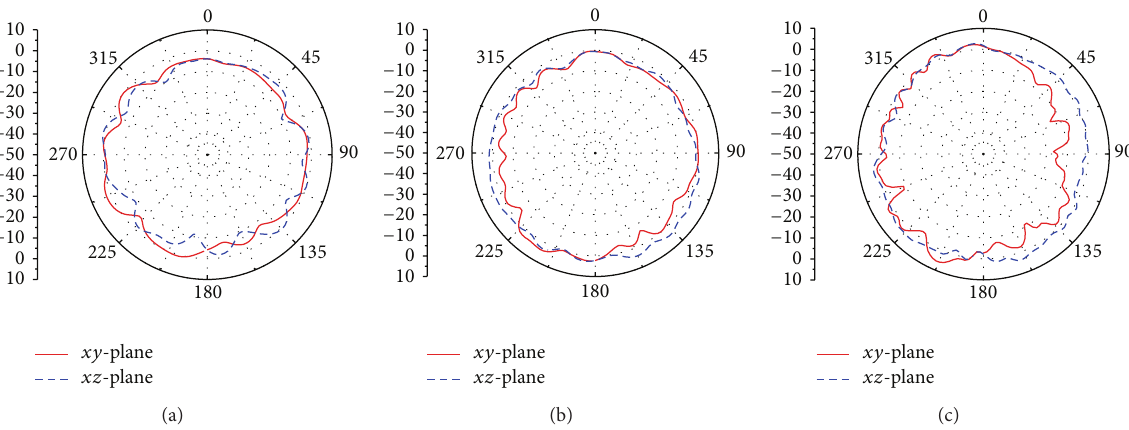
Figure 7: Measured two-dimensional radiation patterns for the proposed antenna at (a) 860 MHz; (b) 1620 MHz; (c) 2620 MHz.